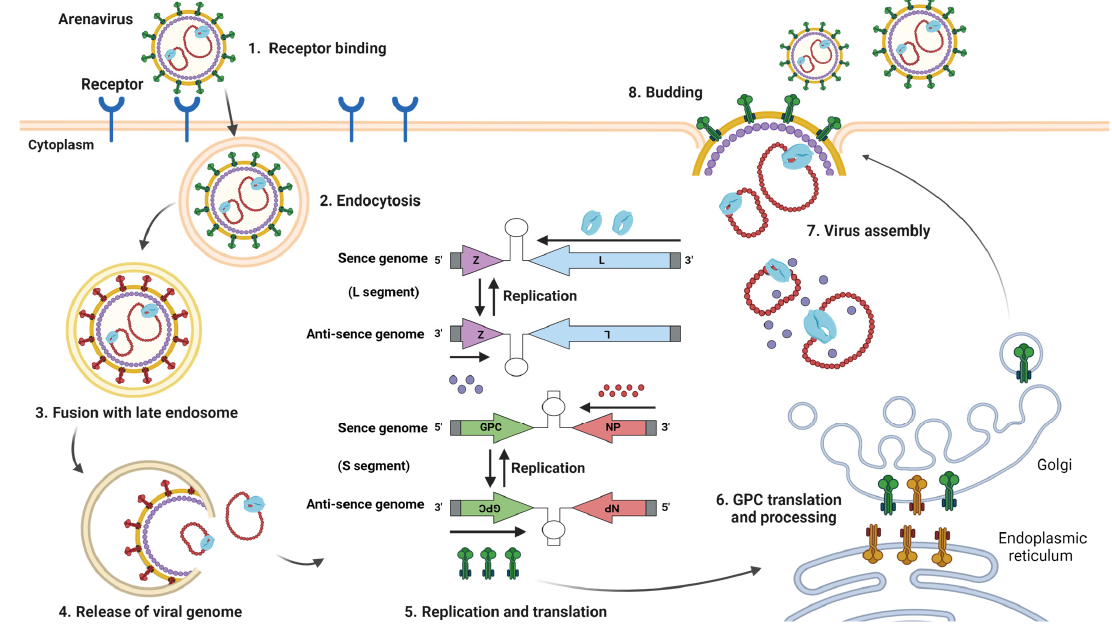
Figure 4. Life cycle of arenavirus. Virus entry into cells is initiated by binding GP1 to cellular receptors (1). Following attachment to the cell surface, viruses are mainly internalized by endocytosis (2). Conformational change of GPC triggered by acidic condition in the late endosomes promotes fusion between the virus and endosome membrane, leading to the release of viral genomes and replication complexes into cytosols (3 and 4). Replication complexes are released into the cytoplasm and initiate replication, transcription, and translation of the viral genome with NP and L. The transcription of viral genes begins at the 3 ′ ends of sense genomic vRNA and complementary anti-sense vRNA. NP and L coding regions are transcribed directly from the vRNA. GPC and Z are translated from anti-sense vRNA. A secondary stem-loop structure within IGRs of the S and L segments is responsible for transcription termination. The anti-sense vRNA serves as a template for newly synthesized vRNA (5). GPC is translated in the endoplasmic reticulum and undergoes N-linked glycosylation and cleavage of SSP by cellular signal peptidase (SPase). GPC is further cleaved into GP1 and GP2 by Subtilisin Kexin Isozyme 1/Site 1 Protease (SKI-1/S1P), and finally matured into SSP, GP1, and GP2 in the trans-Golgi network (6). Z protein utilizes the ESCRT pathway to drive transportation and assembly of viral components such as NP, L, and replication complexes at the plasma membrane. Z protein also interacts with GPC, mediating the incorporation of viral RNP complexes into GPC containing particles, leading to the release of the progeny virus from infected cells (7 and 8). Figure created with BioRender (https://app.biorender.com, (accessed on 9 March